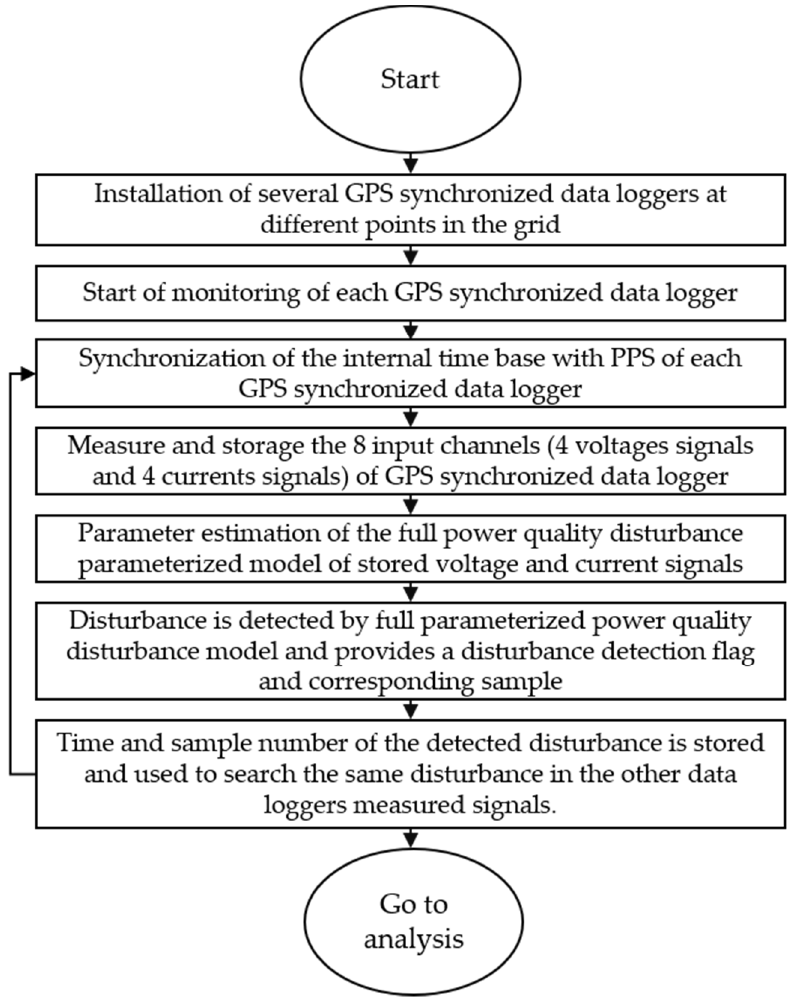
Figure 10. Diagram of the procedure for monitoring a disturbance that propagates in the grid im- plemented in GSD. implemented in